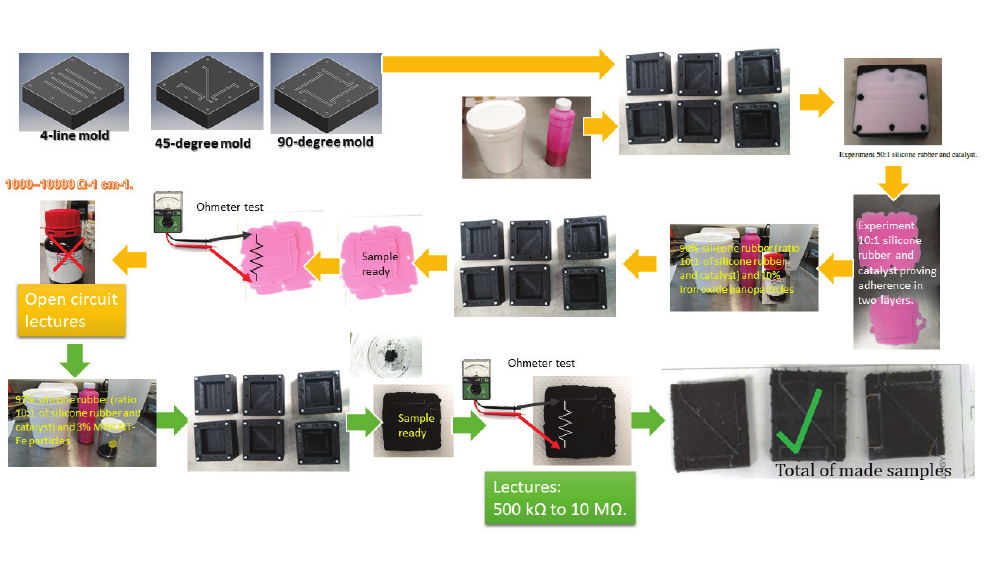
Figure 6. Sequence of experiments during the manufacture of the